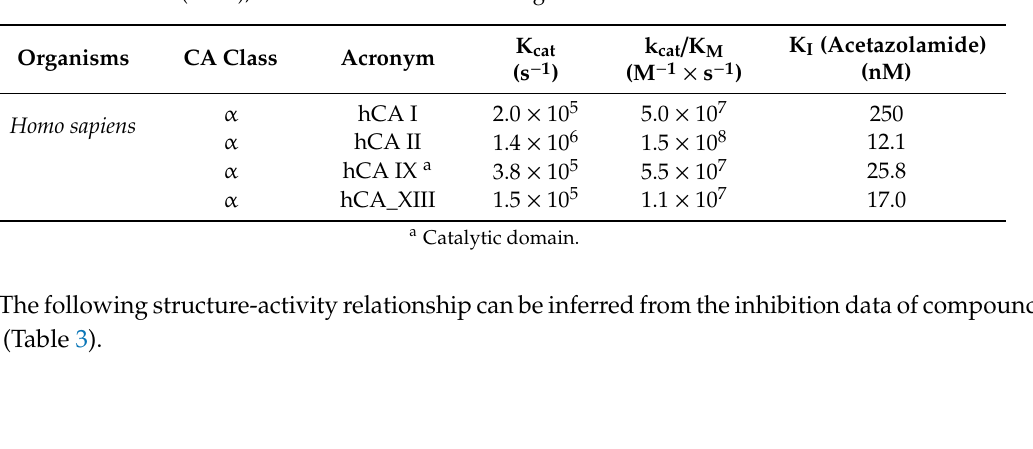
Table 2. Kinetic parameters of the pure CA isoforms employed in this work and inhibition constants for acetazolamide (AAZ), a standard sulfonamide drug.